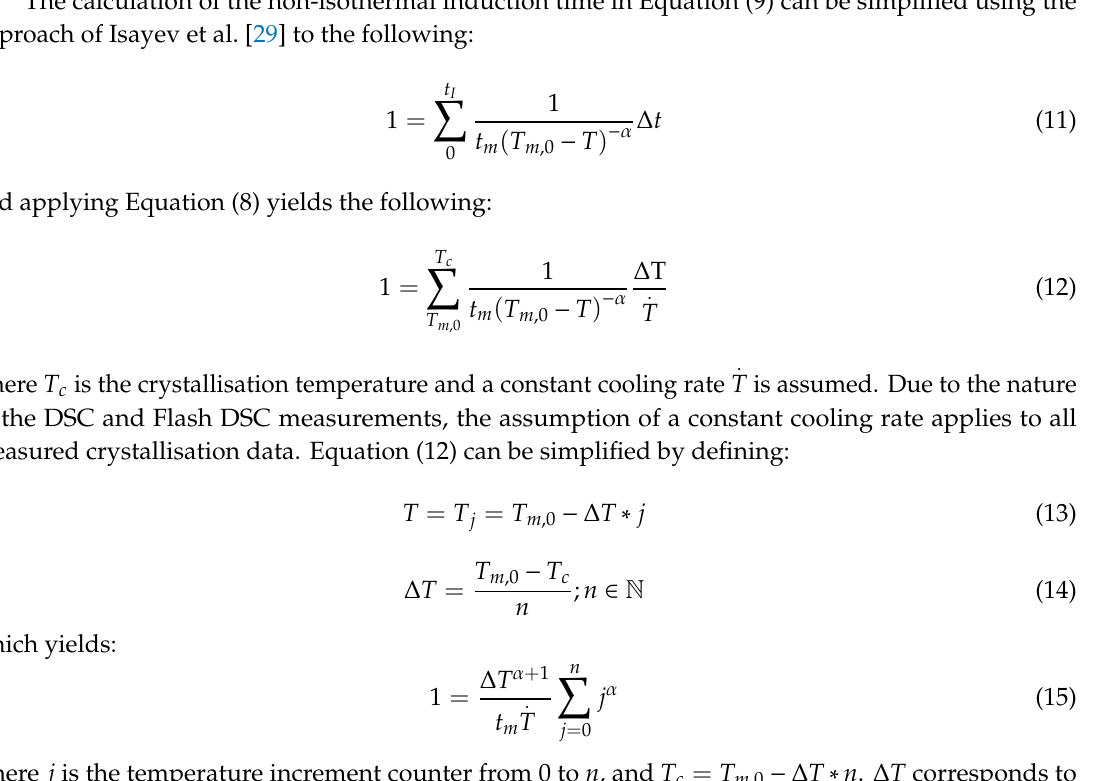
Figure 5. Combining measurements of the isothermal induction time from the literature ( ∆ ) [18] and Flash DSC measurements ( □ ) to fi t both parameters of the Godovsky isothermal induction time model.